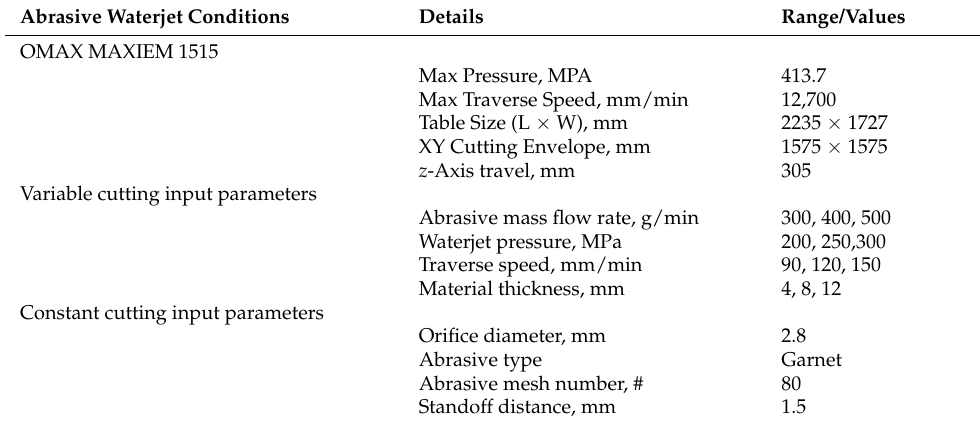
Table 3. Machine specifications and cutting input parameters.